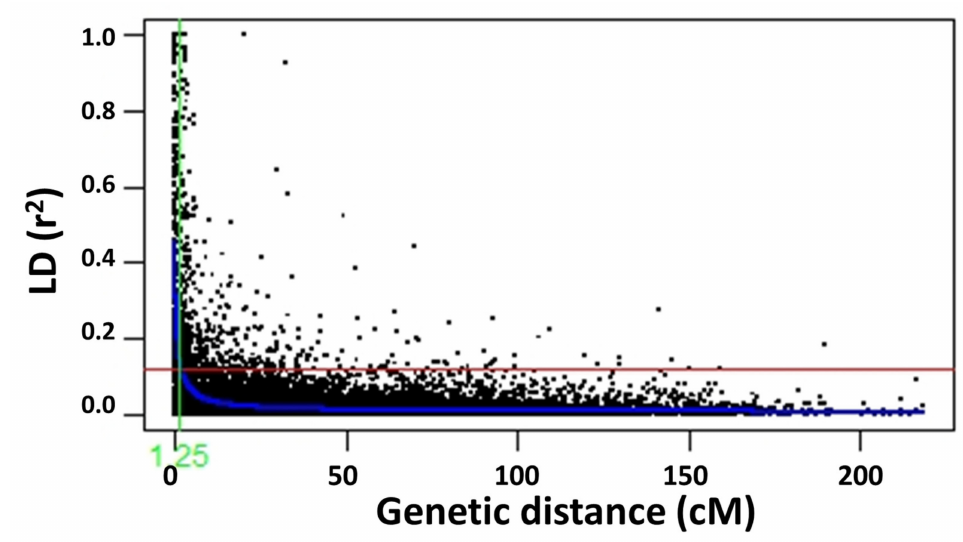
Figure 6. Scatter plot of the linkage disequilibrium (LD) decay with the critical r 2 value and the genetic chromosome distance (cm) for the whole genome. The red line shows the critical r 2 value i.e.,